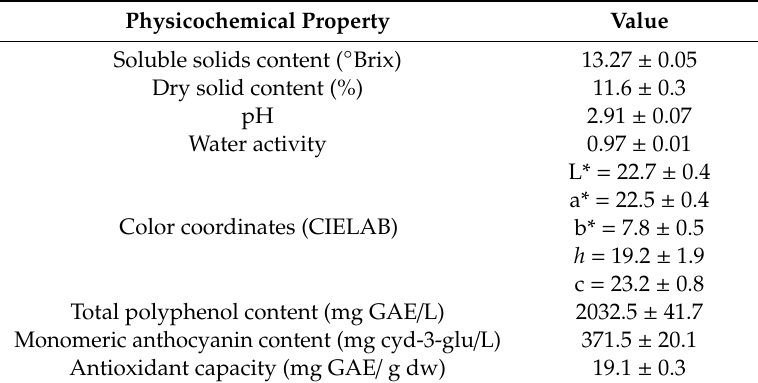
Table 1. Physicochemical properties of the Andean blueberry juice.